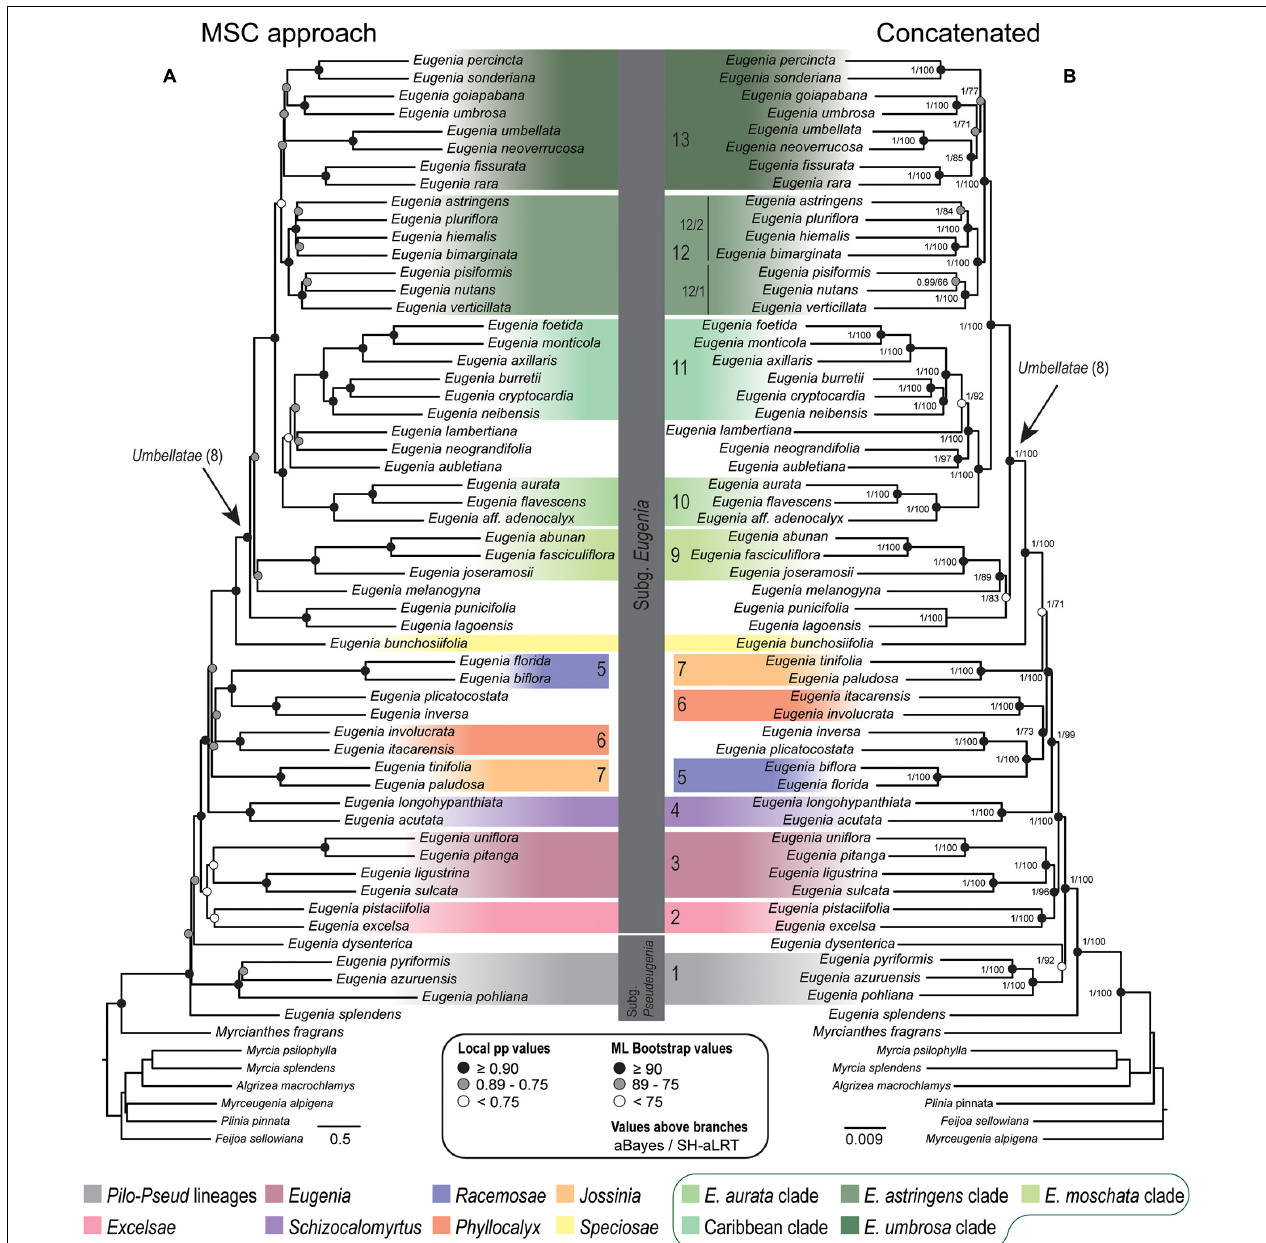
FIGURE 2 | Phylogenetic reconstructions of Eugenia based on the 306 nuclear coding loci (ncCDS) targeted with the Angiosperm-353 probes. (A) Multi-species coalescent (MSC) tree using Astral with support values shown at nodes as local posterior probabilities (pp). (B) Concatenated partitioned tree with ML support shown at nodes as circles (see legend) and additional tests of branch support with values above branches (aBayes/SH-aLRT). Colored legend corresponds to the colored boxes (clades of Eugenia sect. Umbellatae are